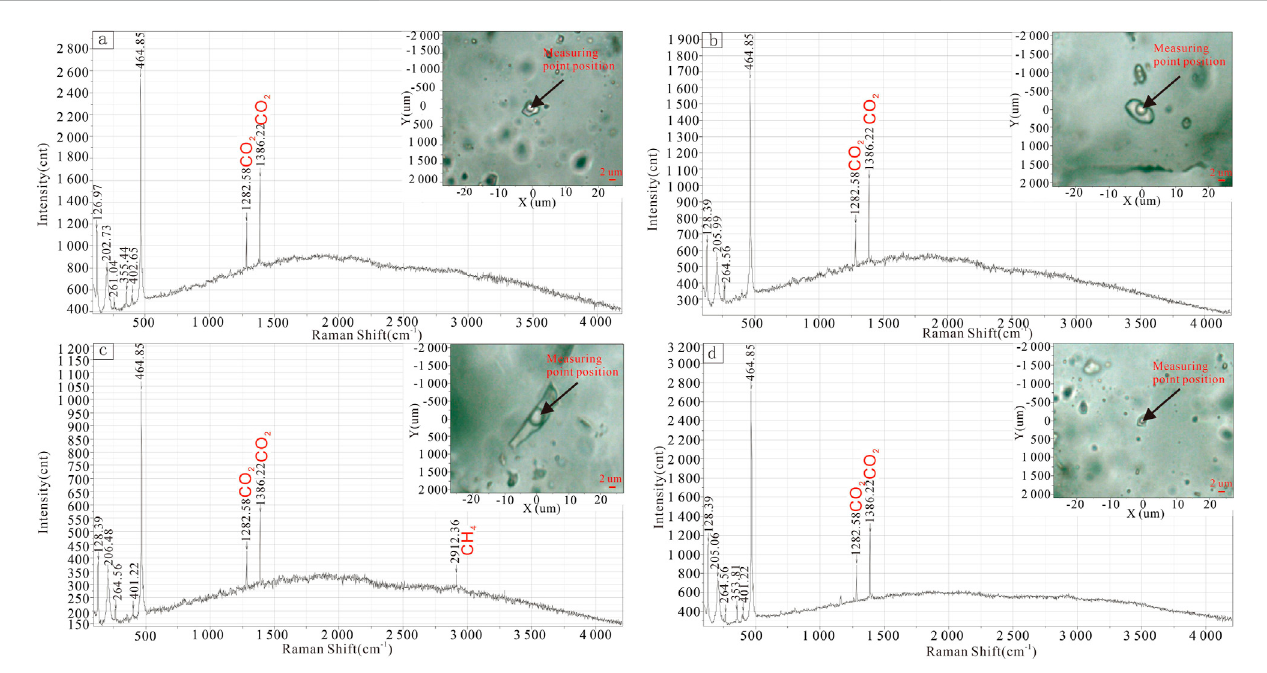
FIGURE 10 Laser Raman spectra of the ore-stage fl uid inclusions from the Zhaoxian gold deposit: (A) and (B) CO 2 inclusions in the early ore-stage; (C,D) CO 2 and CH 4 inclusions in the main ore-stage.